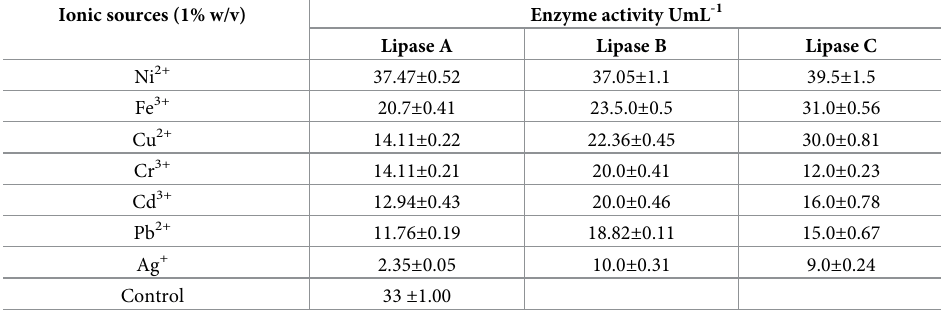
Table 6. Effect of metal ions on lipase production from B . cereus NC7401 cultured using starch (Lipase A), malt- ose (Lipase B), and tryptone (Lipase